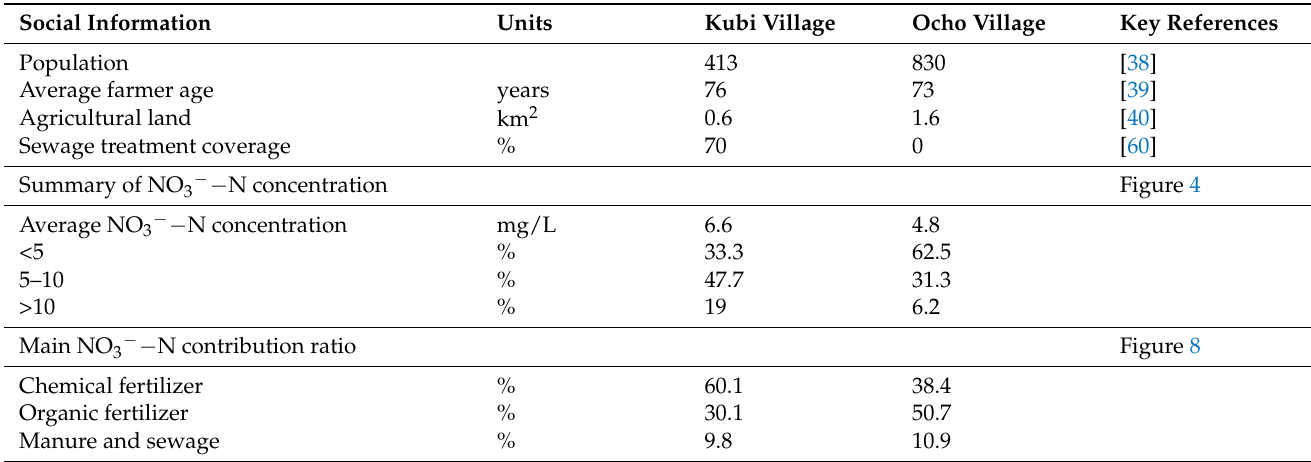
Table 4. A summary of social aspects and groundwater NO 3 − − N contamination status in Kubi and Ocho